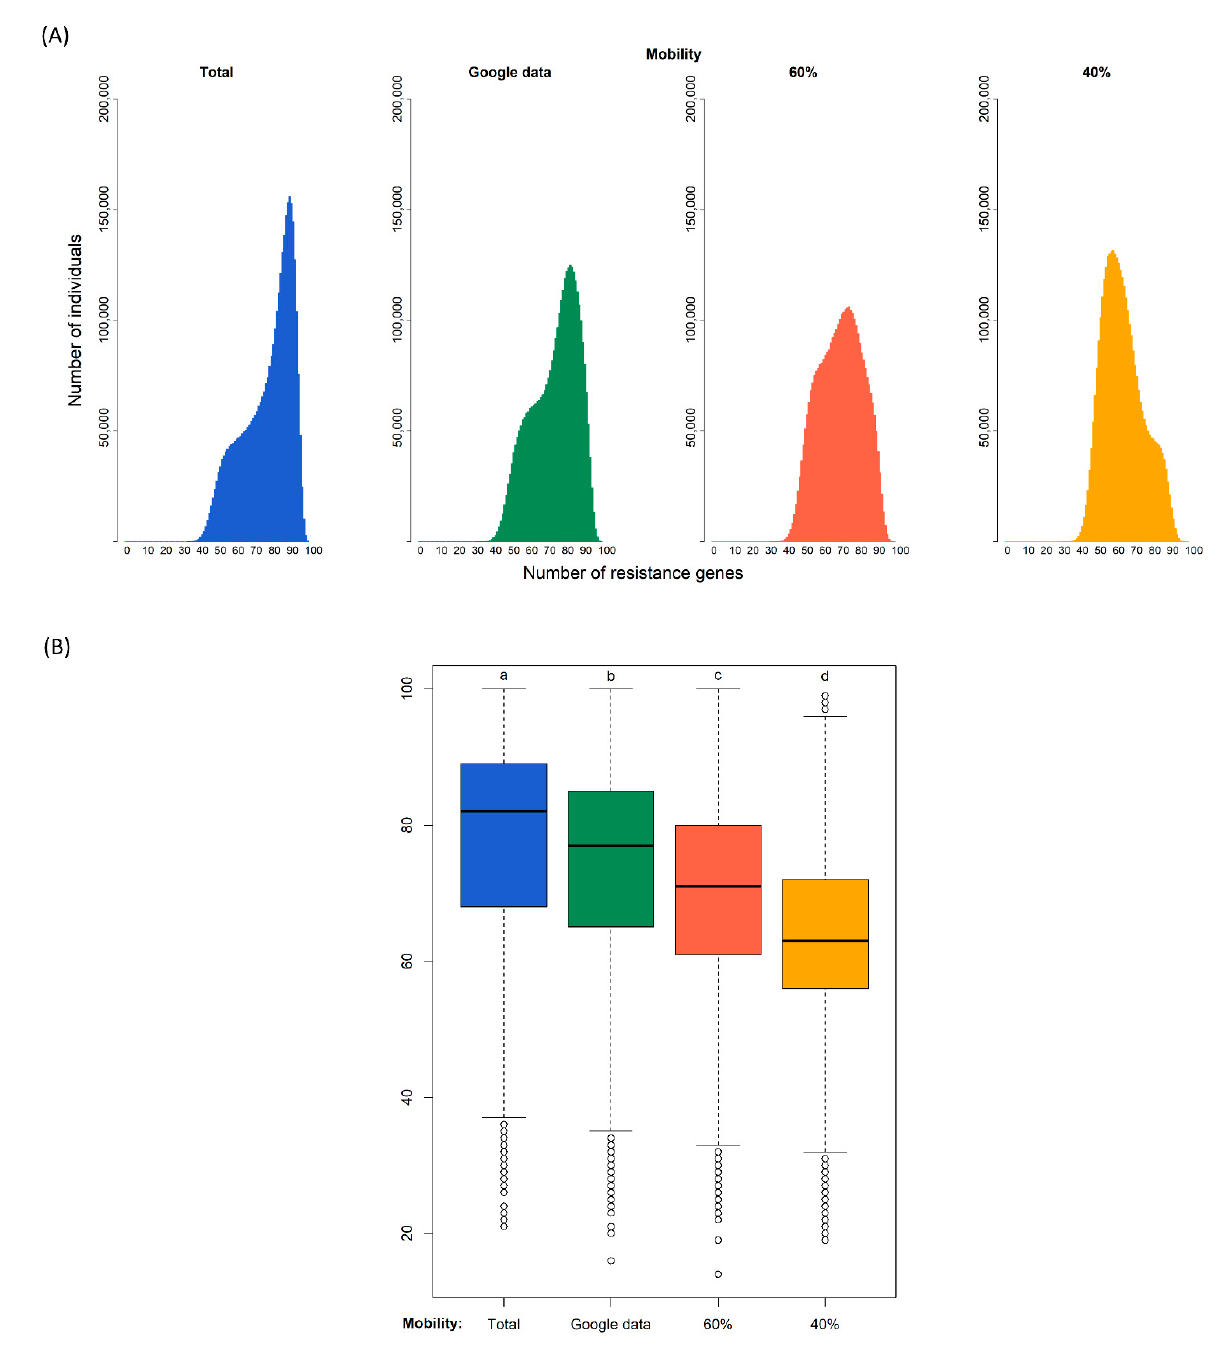
Figure 2. Diversity of resistance genes in four different scenarios of confinement after 180 days. Simulation (i) without confinement (100% of connections); (ii) using the real mobility data from Google assuming that a certain reduction of mobility corresponds to a similar reduction of connections; and with a fixed proportion of connections of (iii) 60% and (iv) 40%. ( A ): Distribution of the predicted number of antibiotic resistance gene types among individuals at the end of the simulation. ( B ): Each box plot represents the distribution of values: the bottom and top of the box are the first and third quartiles, the horizontal line is the median, the vertical lines are the 1.5 interquartile range. Black circles represent outliers. After a Kruskal–Wallis analysis (see main text), post hoc comparisons using the Dunn test indicated that the effect of confinement is significantly different in the four confinement types as indicated by the four different letters a, b, c, and d ( p -value < 0.000).